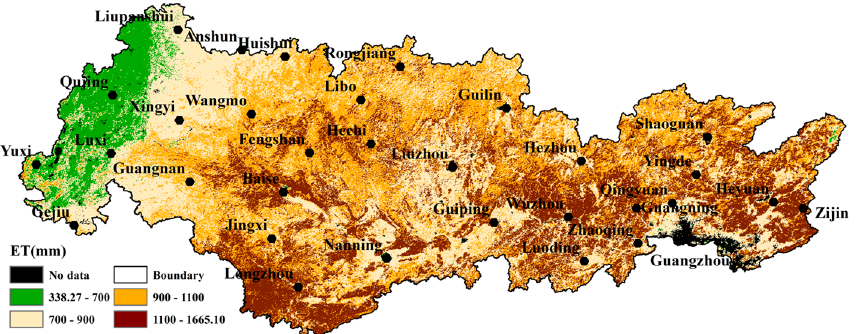
Figure 6. Spatial variation in monthly ET in the PRB.